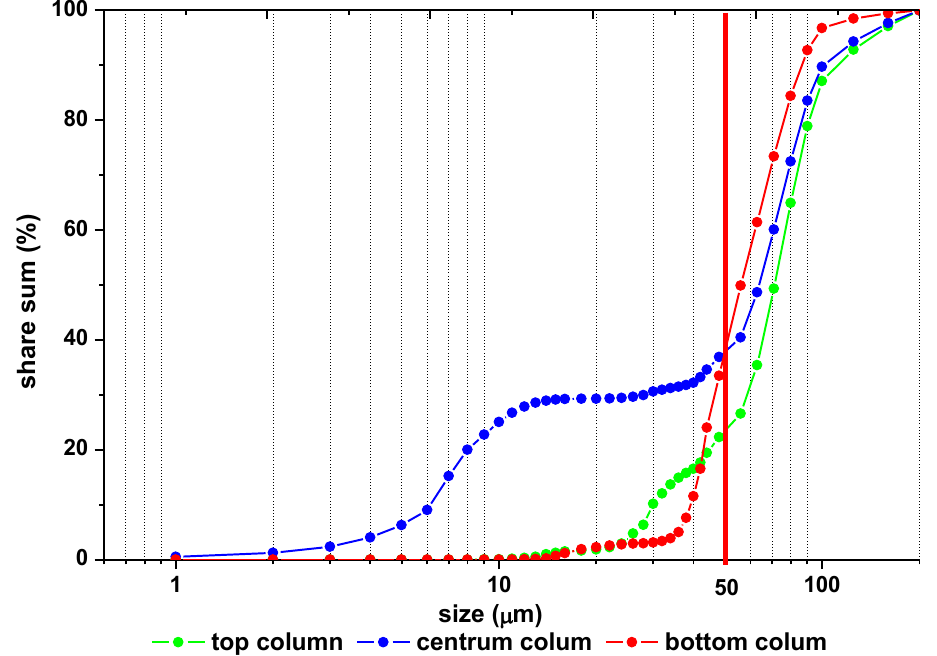
Figure 12. Distribution of grain classes at each level of column 3.